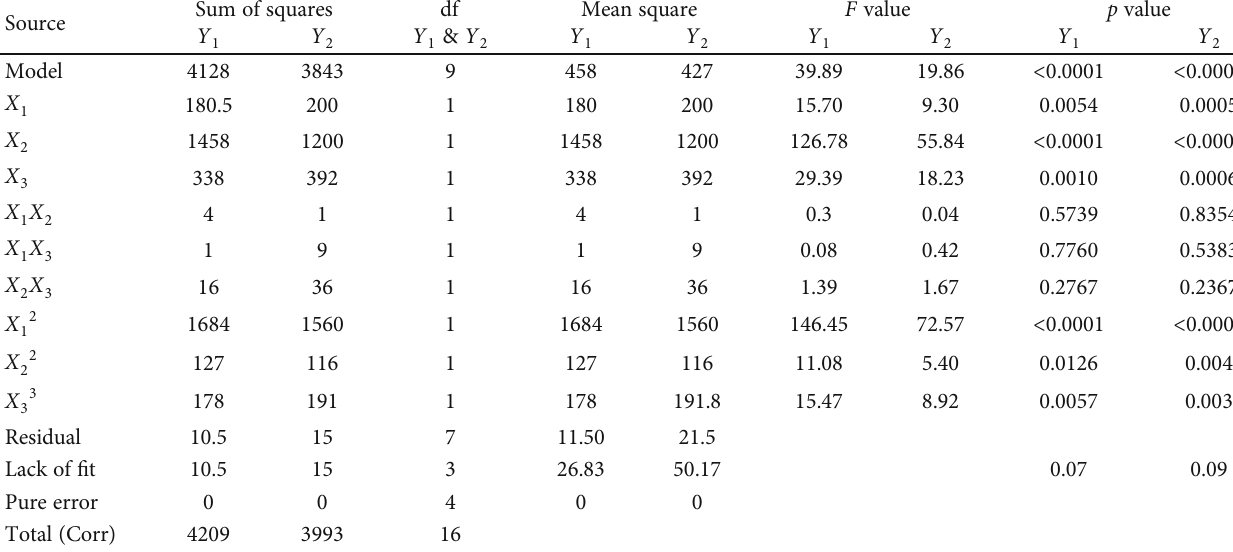
Figure 2: Predicted versus actual plots for decontamination of NO Table 4: ANOVA test for response